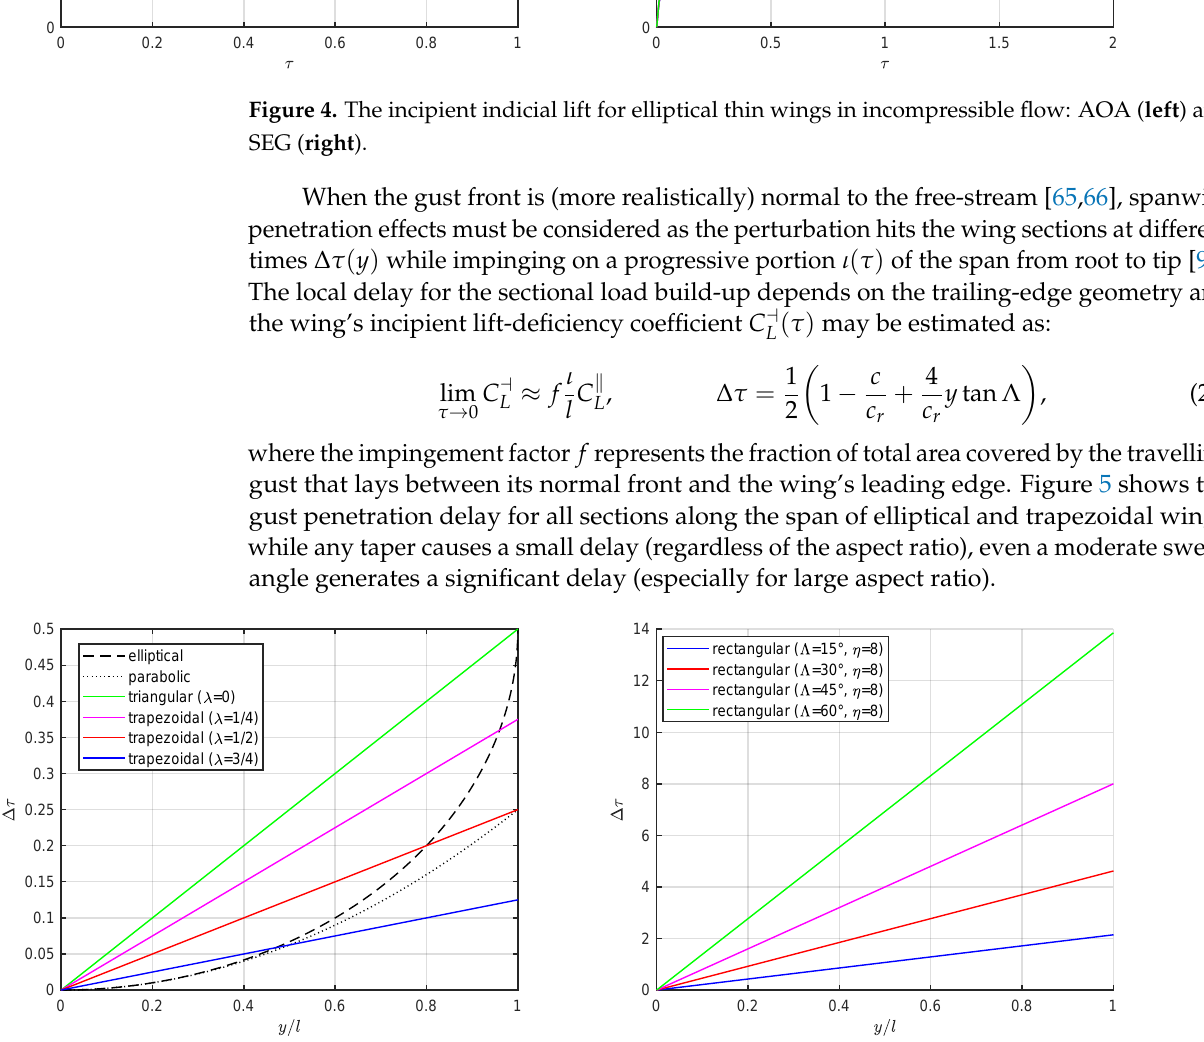
Figure 5. The gust penetration delay for thin elliptical and trapezoidal wings: taper ( left ) and sweep ( right ) effects along the